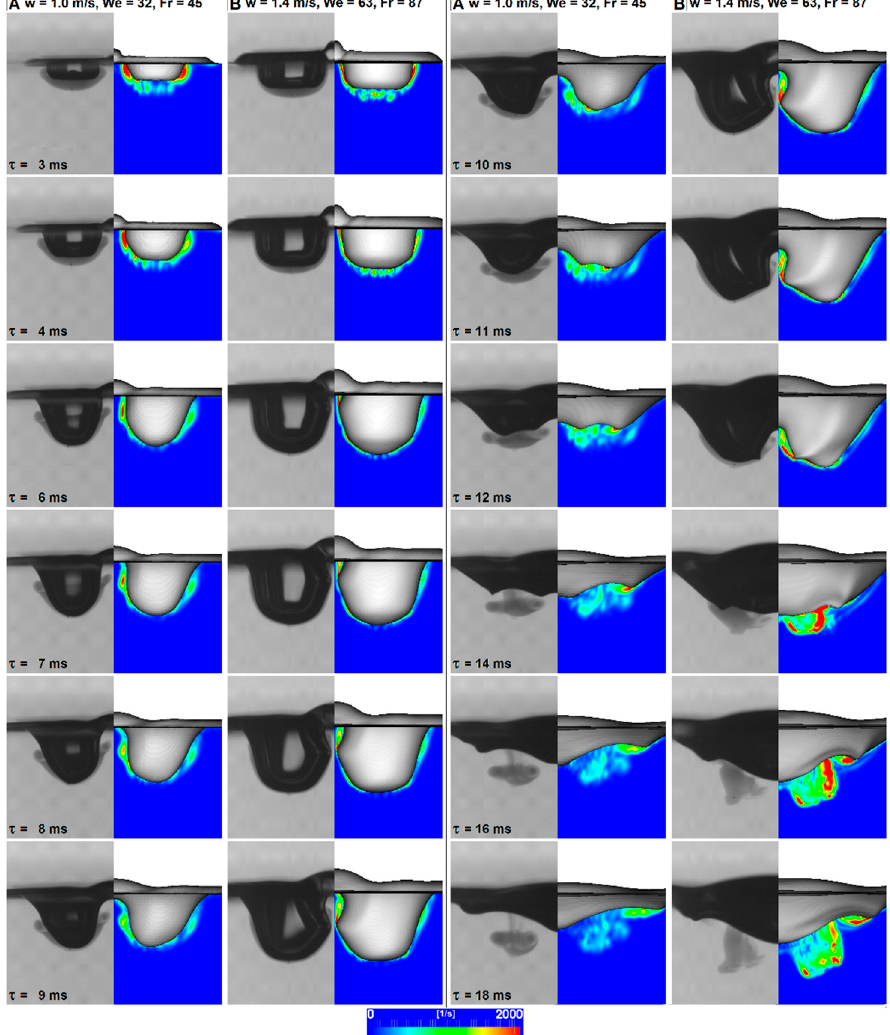
Figure 5. Comparison between the experimentally detected vortex structures and the vorticity Figure5. Comparisonbetweentheexperimentallydetectedvortexstructuresandthevorticitycalculated calculated by numerical simulations, for cases A and B, time up to 18 ms. by numerical simulations, for cases A and B, time up to 18